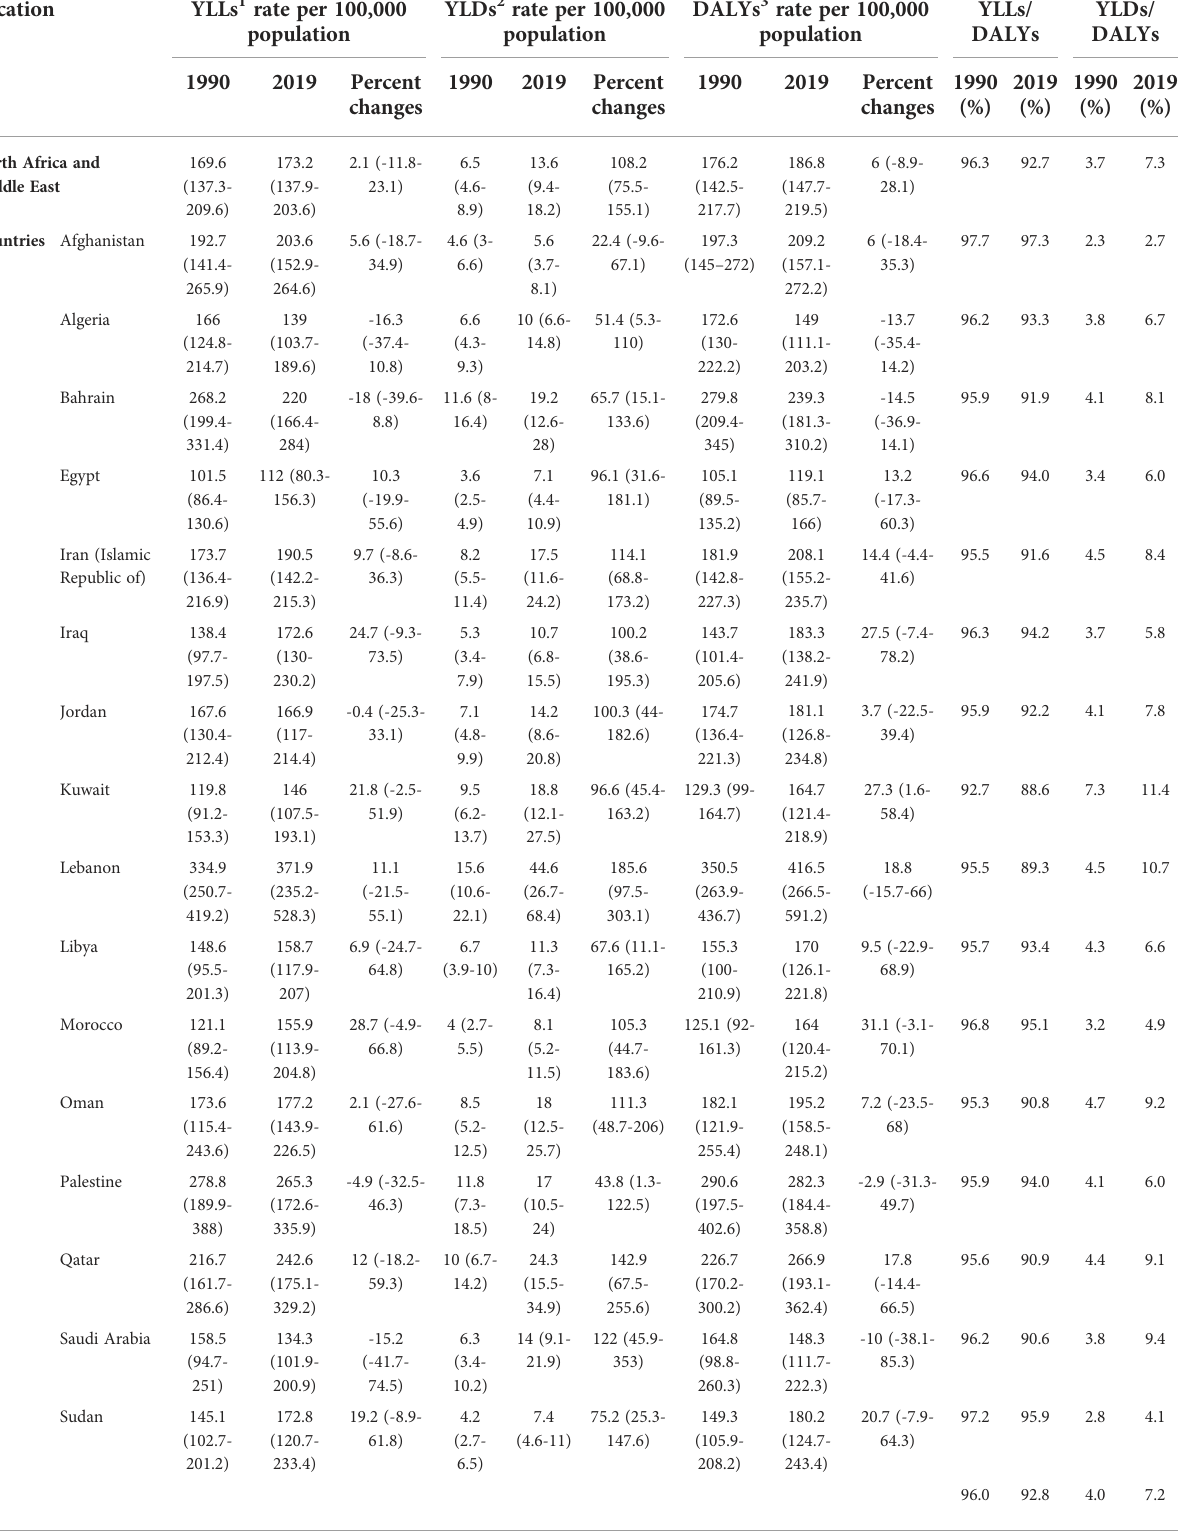
TABLE 2 Age-standardized YLLs, YLDs, and DALYs rate (95% UI) due to prostate cancer in 1990 and 2019 and their percent changes along with YLLs/DALYs and YLDs/DALYs.